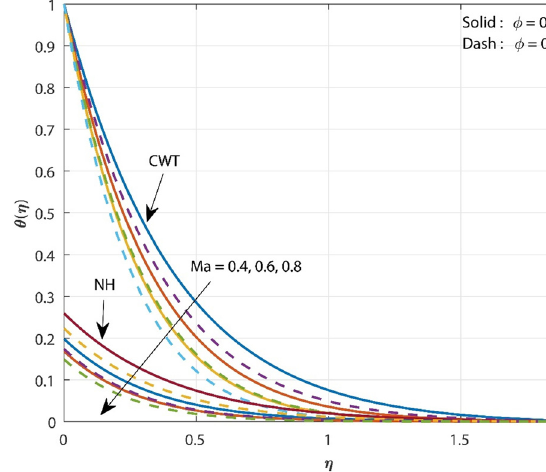
Figure 4: Plot of f ′ ( η ) over di ff erent values of ϕ .